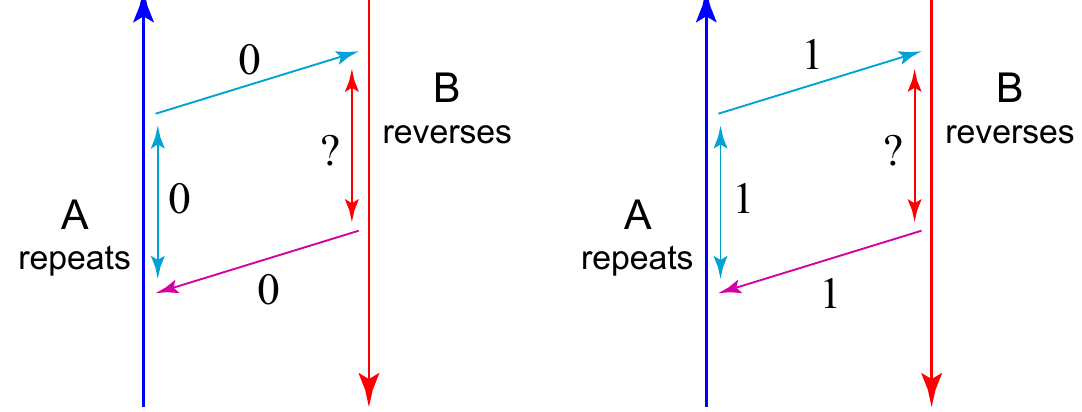
Figure 2: An illustration of the two machines gedanken experiment. Machine A posts 0 (1) if it receives 0 (1), whereas machine B posts 0 (1) if it receives 1 (0). The paradox is symmetric, but for simplicity it is shown to reside on the B